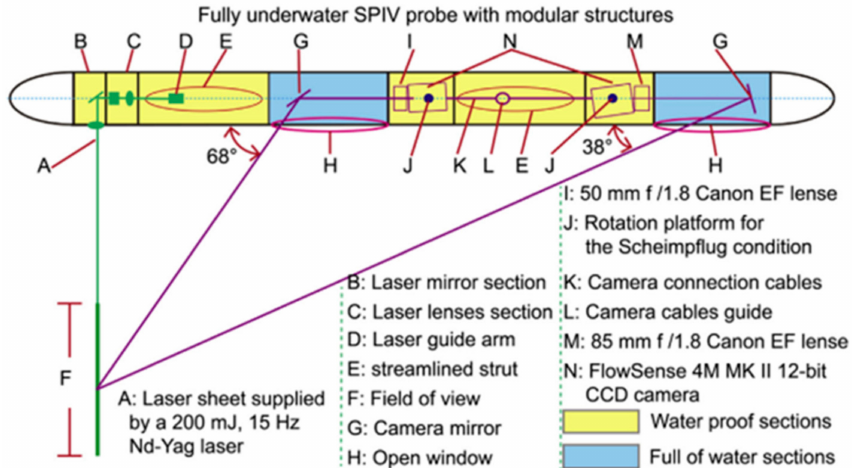
Figure 4. The detailed configuration of PIV equipment.